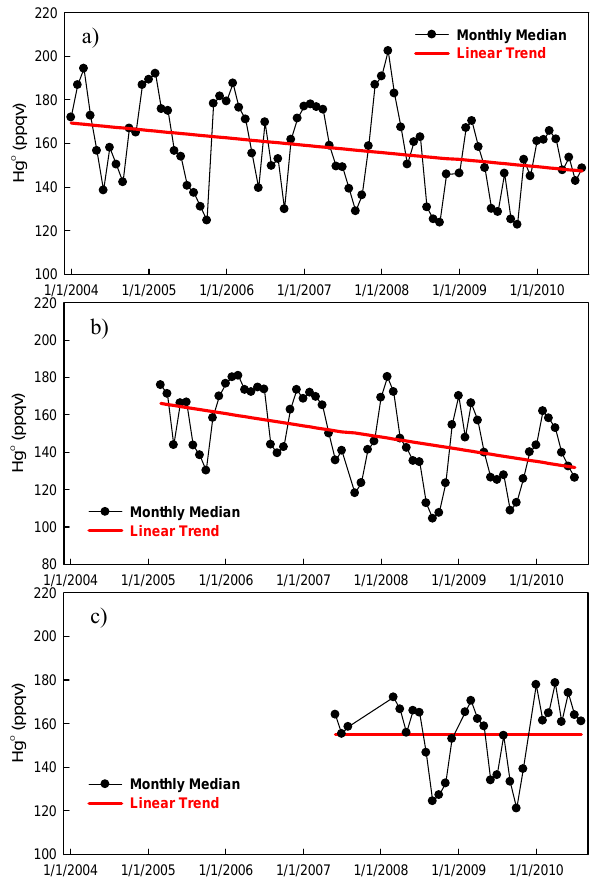
Fig. 4. Monthly median mixing ratios of background Hg 0 at Figure 4. Monthly median mixing ratios of background Hg  at a) Thompson Farm (TF) (a) Pac Monadnock (PM) (b) , Appledore Is- Thompson Farm (TF), b) Pac Monadnock (PM), and c) Appledore Island land (AI) (c) . (AI).